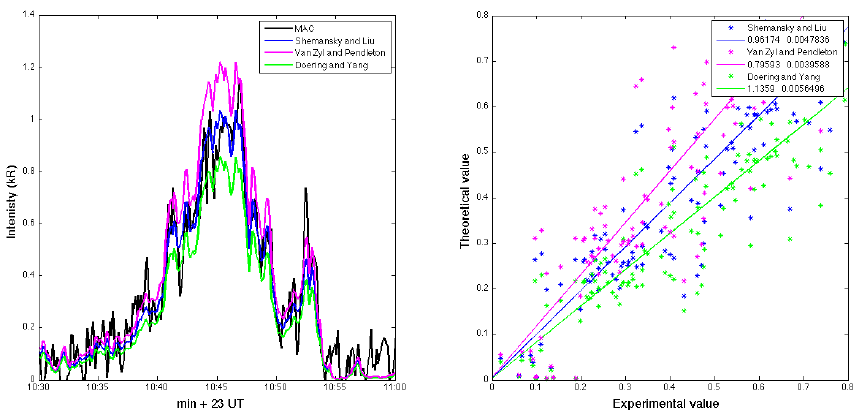
Figure 8. Left: Comparison between the measured intensity of 427.8 nm emissions and the modeled emission using cross sections from Shemansky and Liu (2005), Van Zyl and Pendleton (1995) and Doering and Yang (1997). Right: Linear regression plot between experimental and modeled